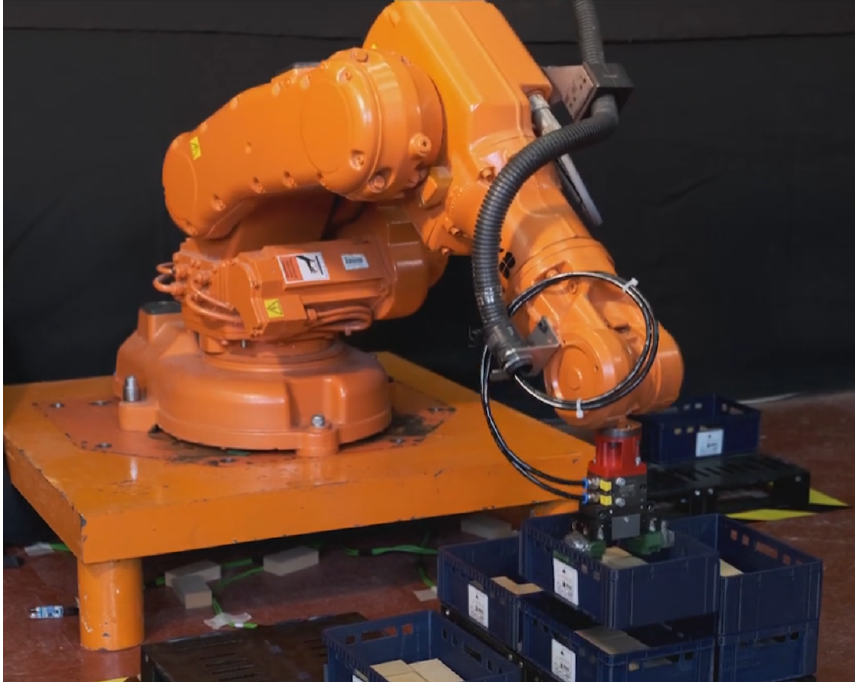
Figure 7. Setup of an industrial robot station with surrounding EURO pallets in the